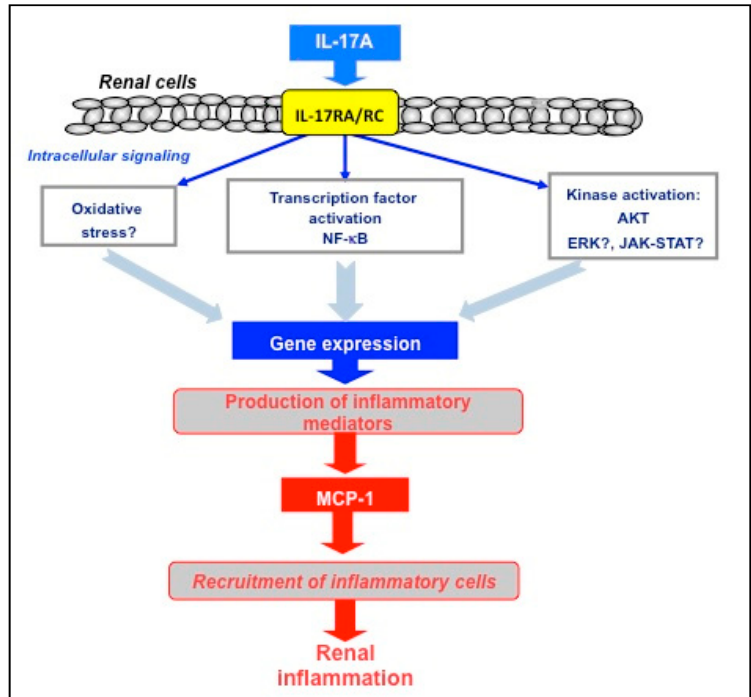
Figure 3. Intracellular mechanisms involved in inflammatory responses of IL-17A in the kidney. IL-17A can binds to its receptors and activates several intracellular mechanisms. The activation of